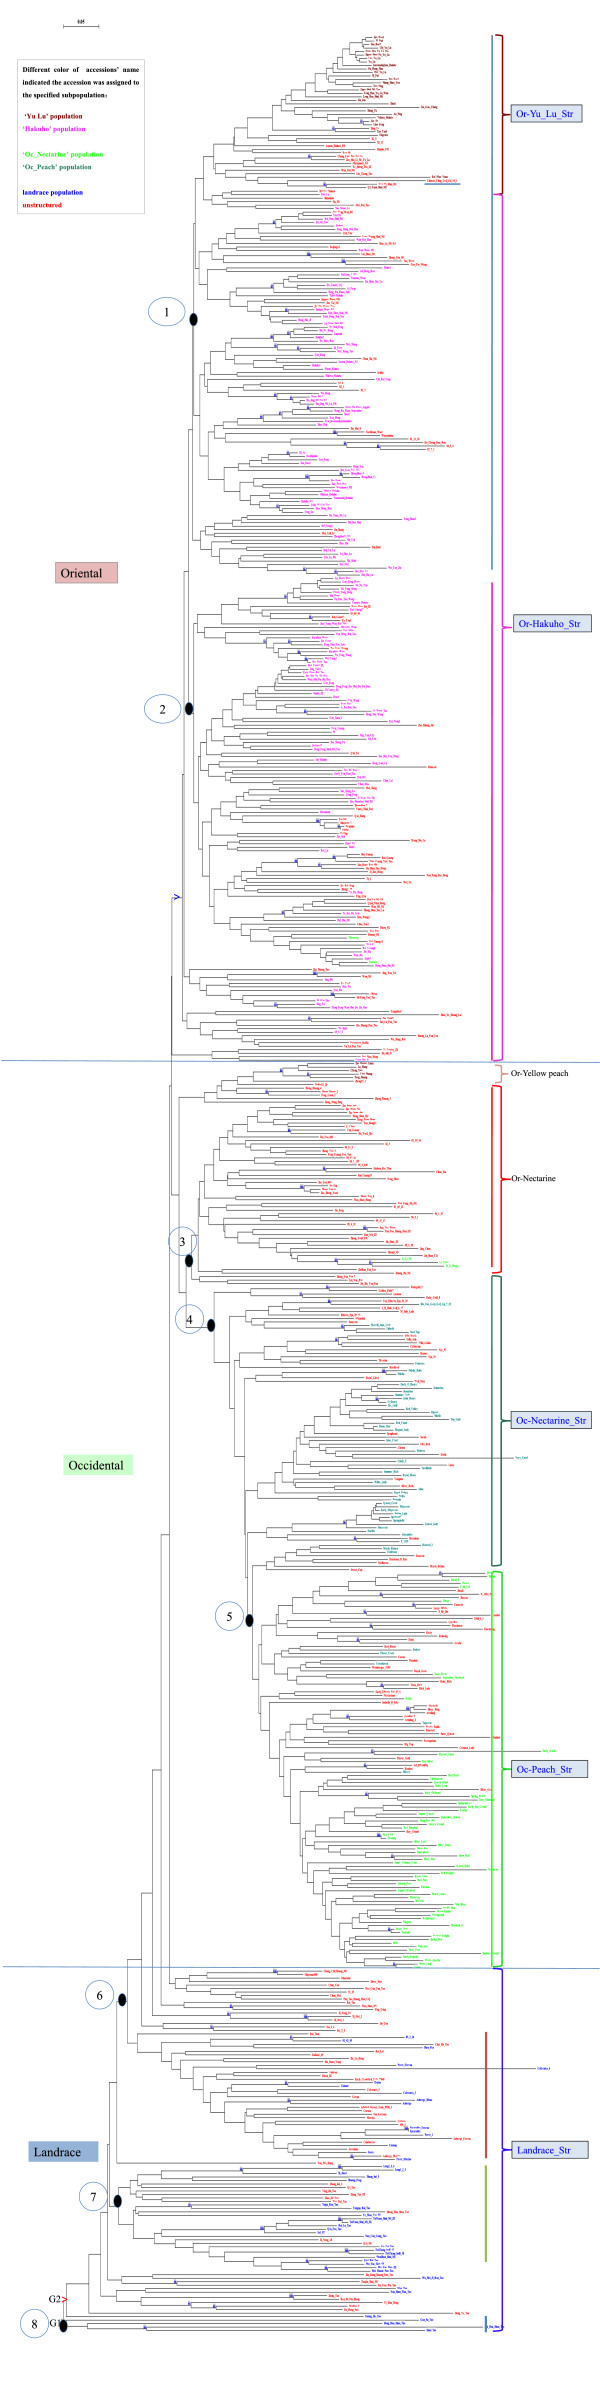
Neighbour-joining tree for the 658 prunus accessions. The tree was rooted using one wild relative species ‘Guang He Tao’ (Prunus mira. Koehne.) as outgroup. Bootstrap support values greater than 80% are shown in blue on the branches. Circled numbers beside the tree nodes indicate the 8 major groups. The colored parentheses indicate the clusters inferred by STRUCTURE analysis of 5 populations. The population ID are noted on the right. Accessions in different colors indicate they were assigned to corresponding populations. Unstructured accessions are in red.